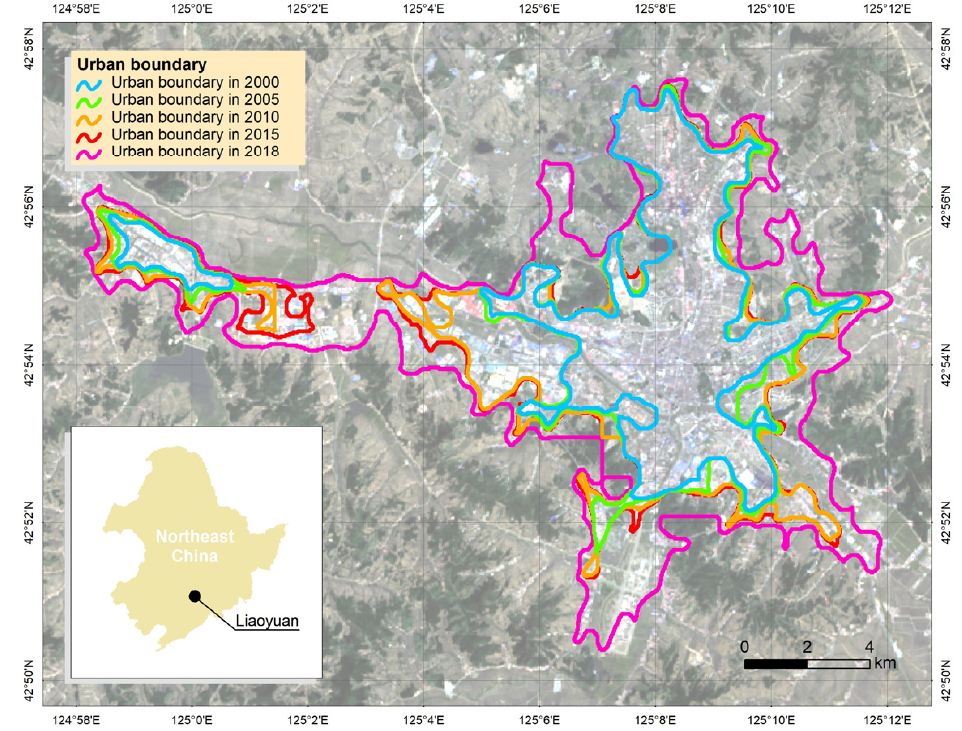
Figure 1. The location and areal extent of Liaoyuan city. The urban boundary data are published by [ 28 ] .